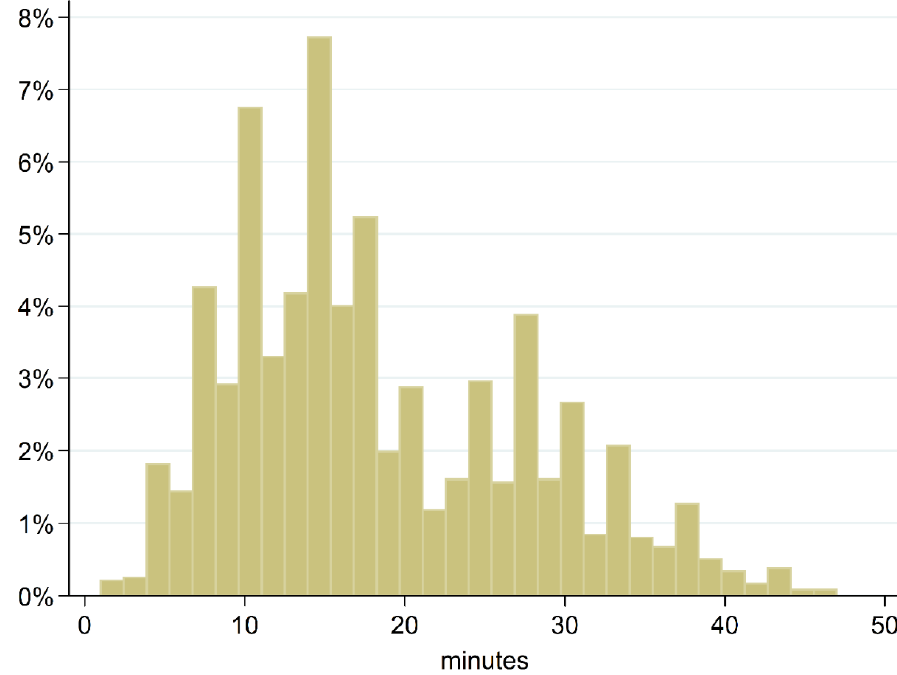
Figure 6. Distribution of travel time to the station.